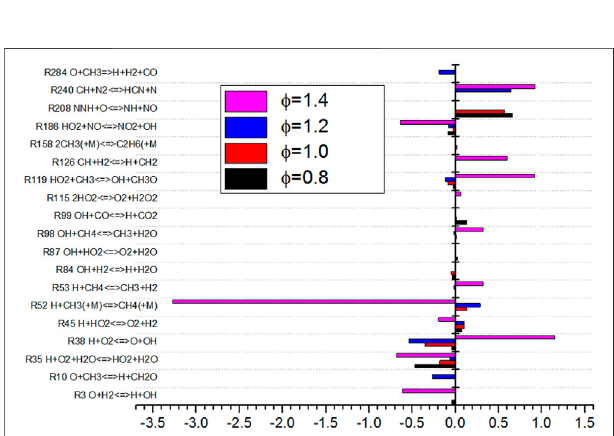
FIGURE 14 | Diagram of sensitivity analysis for NO generation in equivalence